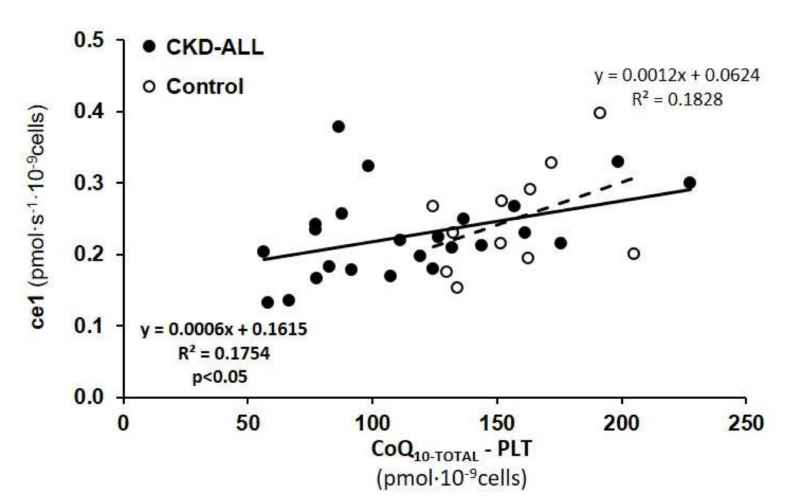
Figure 4. Correlation between CoQ 10-TOTAL in platelets and the respiration of intact platelets in control subjects and CKD-ALL patients. Legend: ce1—the rate of oxygen consumption in intact platelet; CoQ 10-TOTAL —ubiquinol and ubiquinone. CKD-ALL all patients with chronic kidney disease ( n = 27); Control—the group of healthy subjects ( n = 12). p < 0.05 statistically significant association between CoQ 10-TOTAL in platelets and ce1 in CKD-ALL.